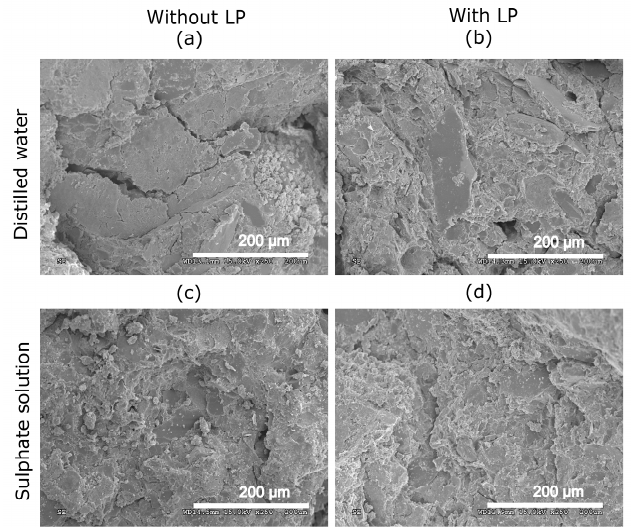
Figure 9. SEM images of lime samples at 6 months ( a ) without the industrial waste and with distilled water, ( b ) with the waste and distilled water, ( c ) without the waste and with the sulfate solution, and ( d ) with the waste and sulfate solution.